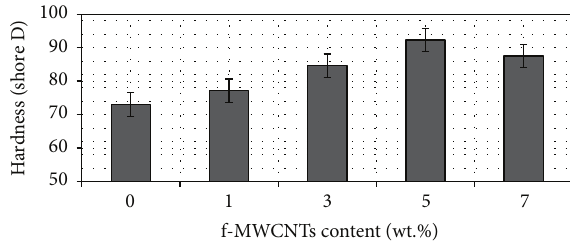
Figure 9: Effect of f-MWCNTs on hardness of